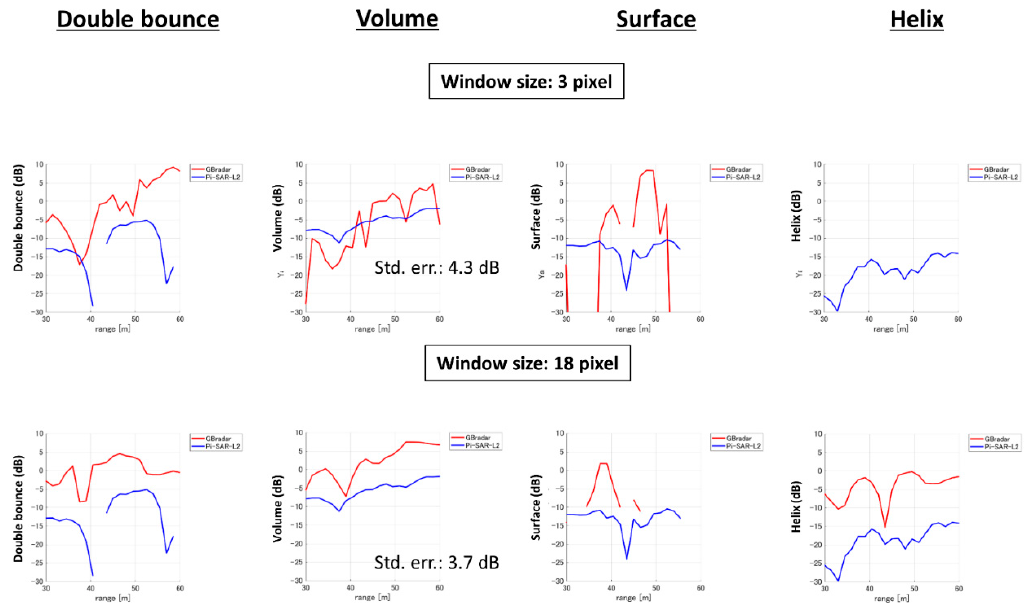
Figure 9. Range profiles of various four-component-decomposition parameters obtained from GB-radar ( red ) and Pi-SAR-L2 ( blue ).